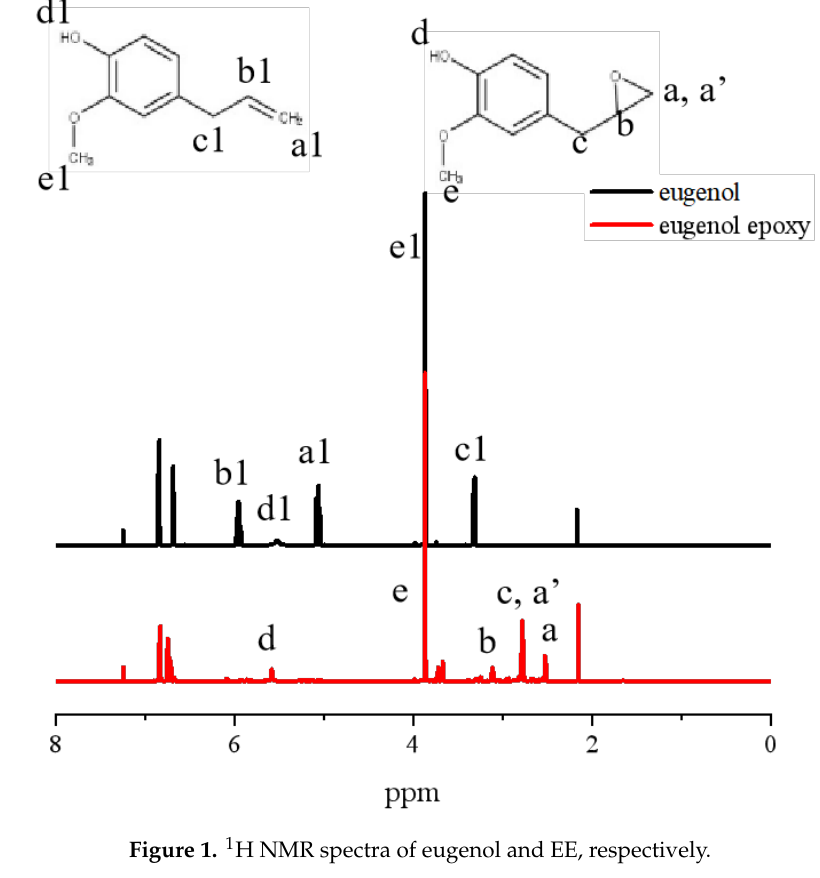
Figure 1. 1 H NMR spectra of eugenol and EE, respectively.